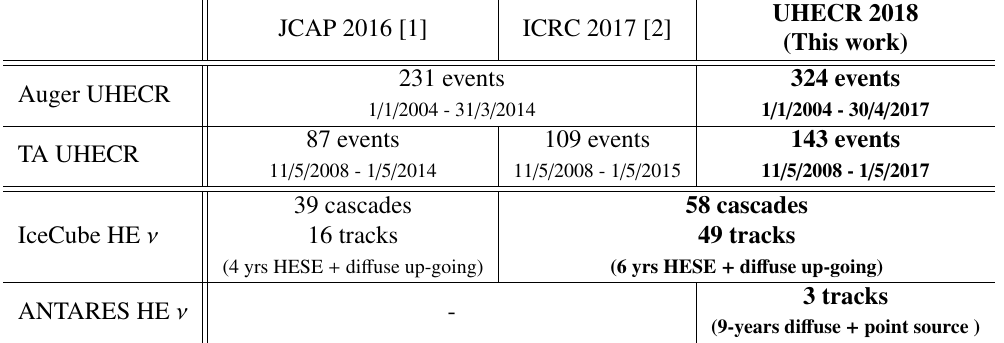
Figure 1. Results of the cross-correlation analysis applied to the neutrino tracks (left) and cascades (right) samples. The relative excess of pairs is shown as a function of the maximum separation angle for data (dots) and expectation from an isotropic distribution of UHECR (colored area, with one, two and three- σ dispersion). Table 1. Summary of the data used in this work compared to previous ones.